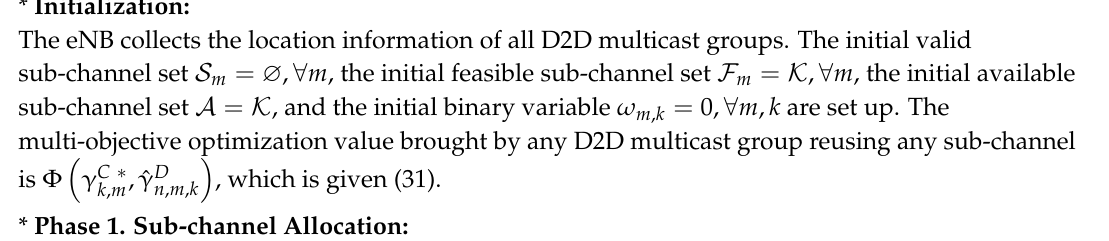
Algorithm 1. Resource Allocation For D2D